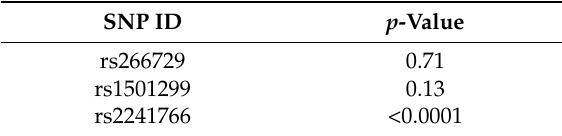
Table 3. The p -value of the exact test of the Hardy–Weinberg equilibrium for rs266729, rs1501299 and rs2241766.